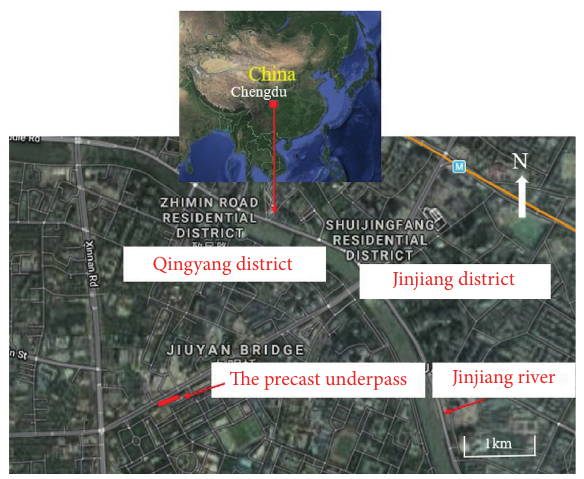
Figure 1: The location of Moziqiao PAU.